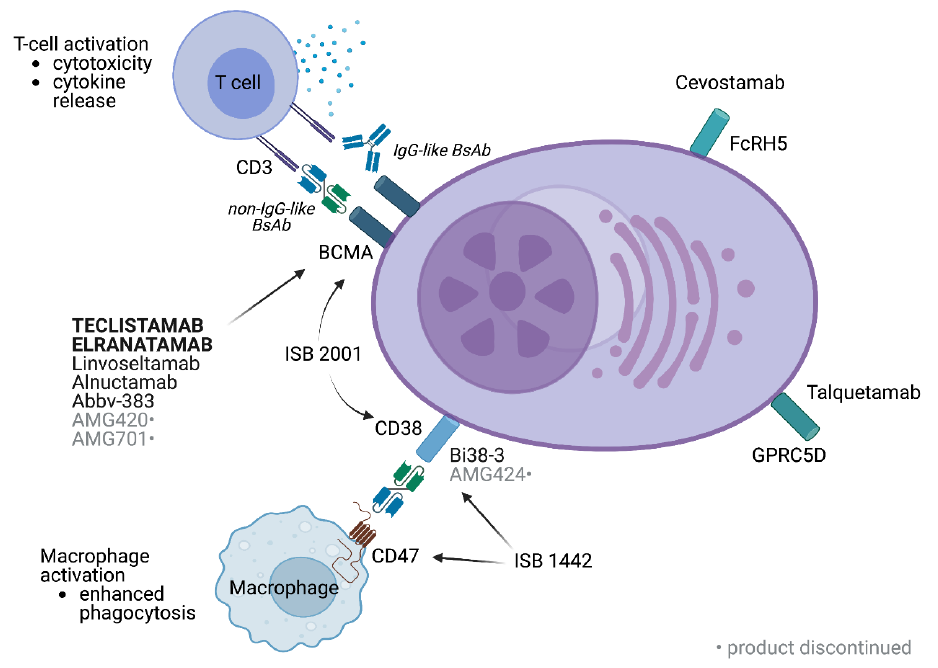
Figure 1. BsAbs under investigation in MM. BsAbs may be IgG-like or non-IgG-like, as shown. The majority of agents target BCMA. Trispecific antibodies such as ISB 2001 may target multiple MM epitopes or enhance immune activation via binding to T cells and macrophages, such as ISB 1442.